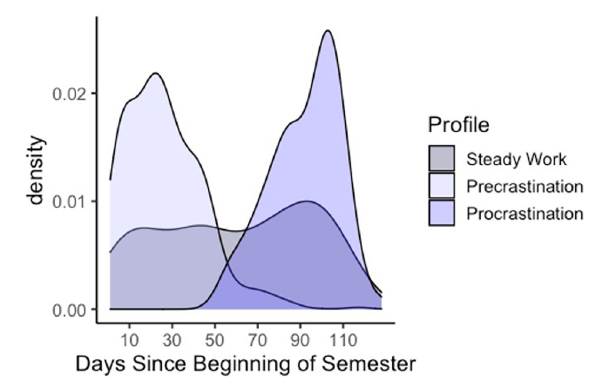
FIGURE 3 | Students’ research credit completion strategies were identified as precrastination, steady work, and procrastination.